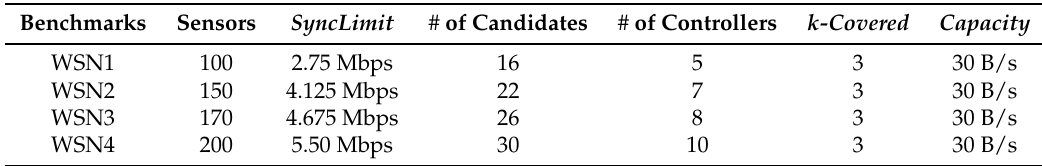
Table 2. System parameters.